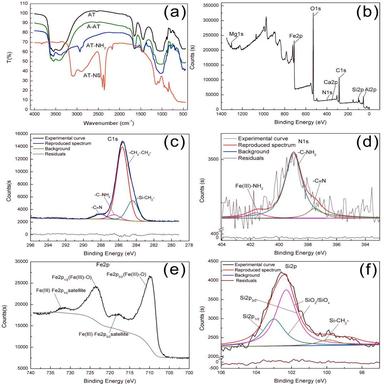
The FTIR spectra (a) the AT, AT-NH2, and AT-NS materials. XPS spectra of AT-NS(b) and the high-resolution XPS spectra of C1s (c), N1s (d), Fe2p (e)and Si2p (f). A Shirley background was used.